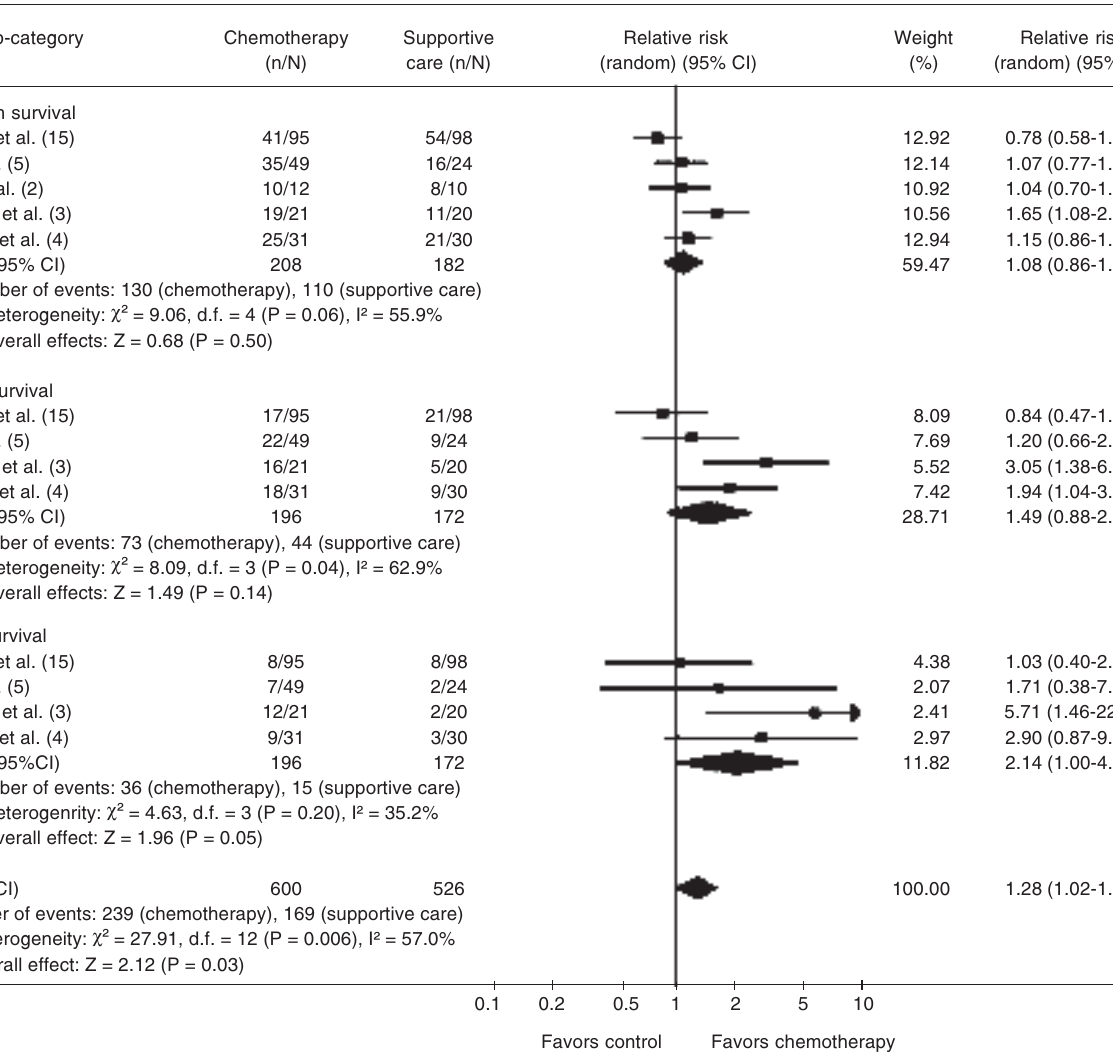
Review: Chemotherapy versus support cancer treatment in advanced gastric cancer: a meta-analysis Comparison: 1 chemotherapy versus supportive care treatment Outcome: 1